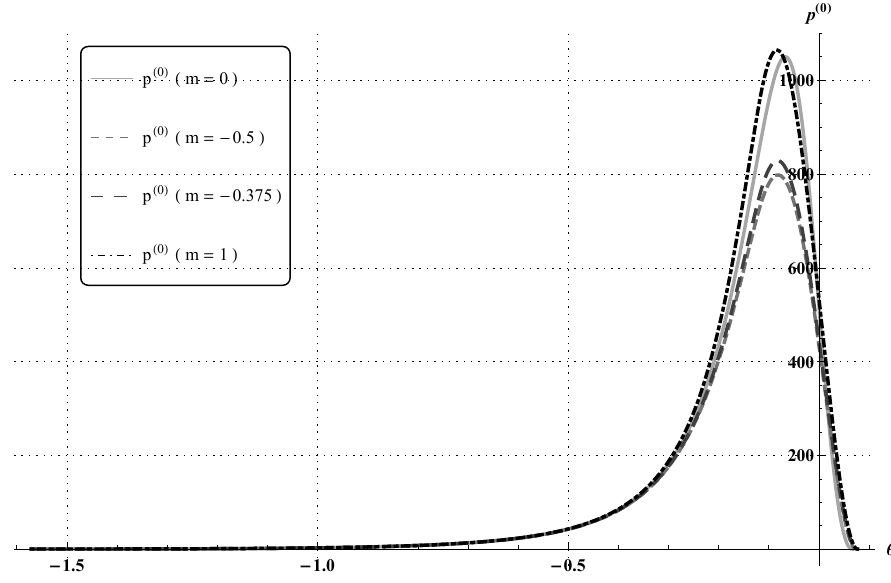
Figure 5. Pressure distributions computed from the classical Reynolds equation, p ( 0 ) ( θ ) ( m = 0 ) , and from the power-law system of Reynolds type equations, p ( 0 ) ( θ ) ( m = − 0.5, − 0.375,1 ) , with (cid:101) = 0.01 and α 0 = O ( (cid:101) 2 )